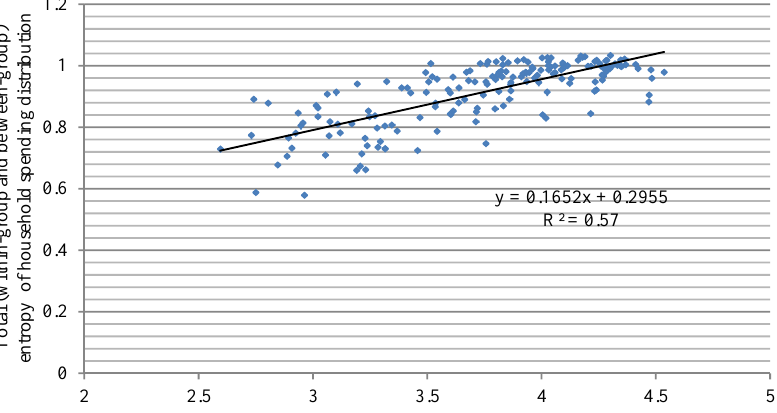
Figure 1. Linear regression for link "the absolute size of household spending — a measure of diversity of consumer spending (total entropy)"